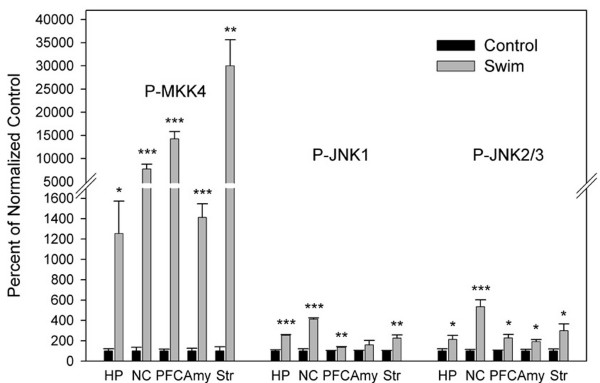
Quantitative changes in P-MKK4 and P-JNK1 and P-JNK2/3 after swim stress. N = 4–6 rats per group. HP, hippocampus; NC, neocortex; Amy, amygdala; other abbreviations and statistics as in the legend to Fig. 2.